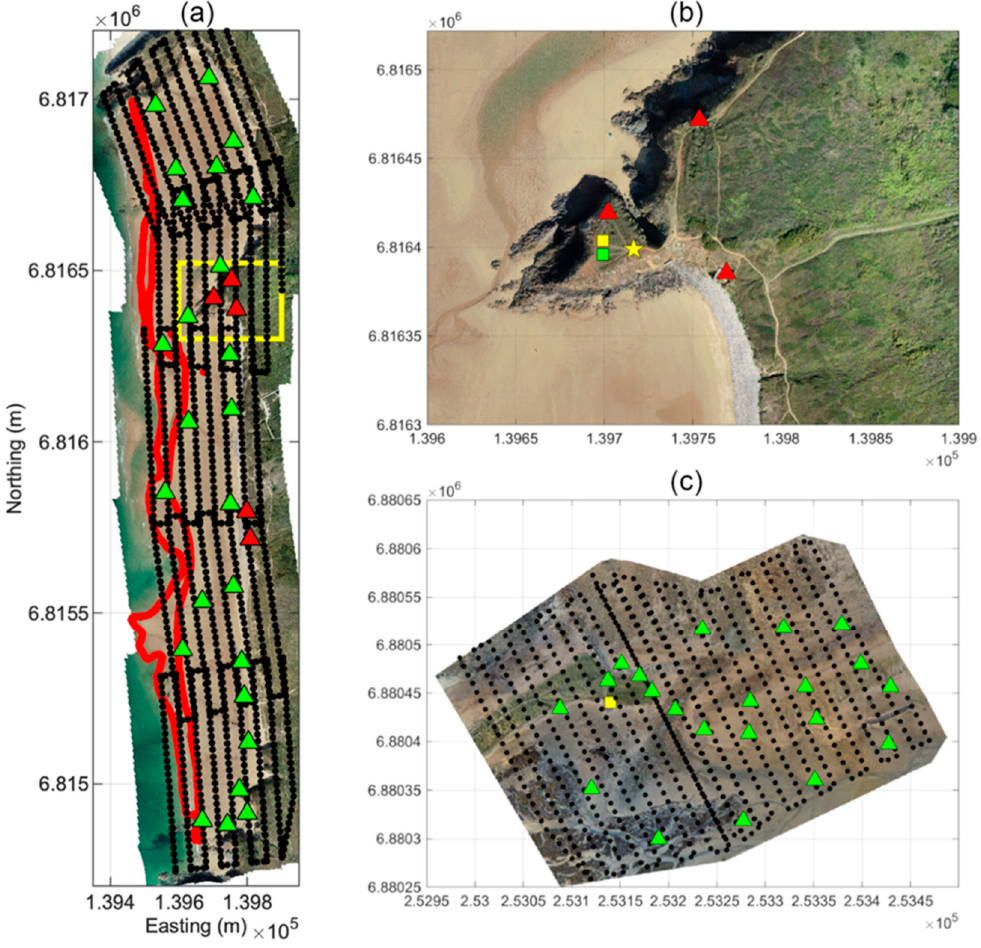
Figure 2. Field surveys. Orthophotos showing camera locations (black dots), DRTK-2 drone mobile station (green square), ground photogrammetric targets (triangles; the five fixed targets present at La Palue during the September survey are shown in red), GNSS base station (yellow square) and geodetic marks (yellow star) at ( a , b ) La Palue, and ( c ) Sillon de Talbert field sites, respectively. RTK-GNSS survey points used for the vertical evaluation of photogrammetry at La Palue are shown in red. At Sillon de Talbert, the GNSS base station and DRTK-2 drone mobile station were installed one after the other using the same geodetic mark.